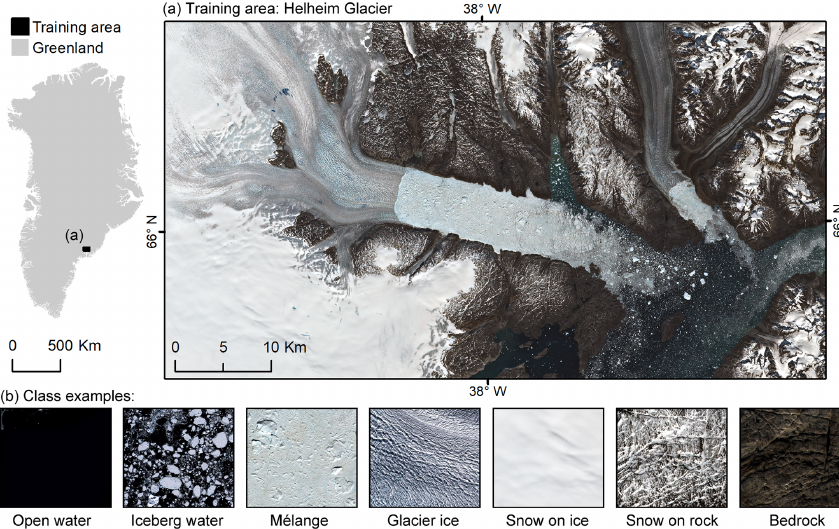
Figure 2. (a) Location of the area from which phase one CNN training data were extracted, showing Helheim Glacier (66.4 ◦ N, 38.8 ◦ W) and the surrounding landscape. Sentinel-2 image acquired on 15 June 2019. (b) Example image samples for each of the seven semantic classes used to train the phase one CNN. The outline of Greenland is from Gerrish (2020), and all Sentinel-2 imagery in this figure has been made available courtesy of the European Union Copernicus